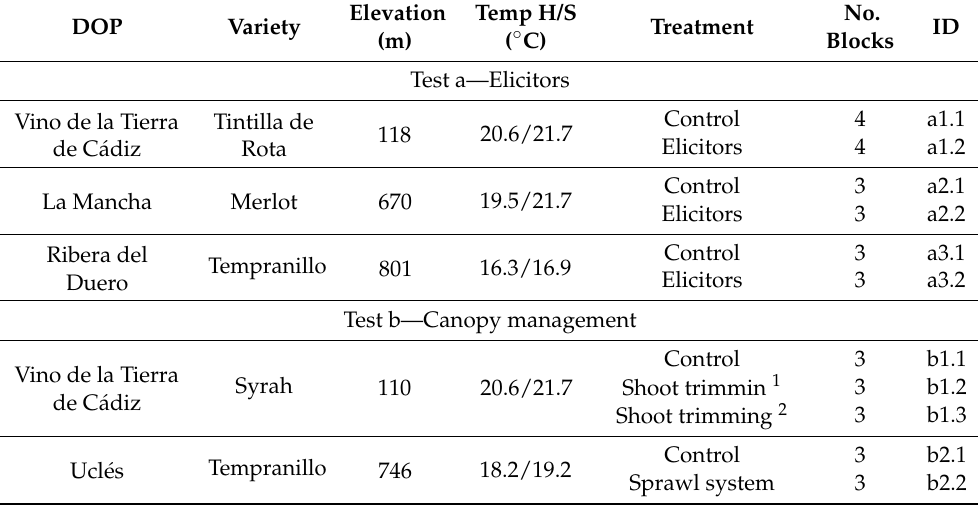
Table 1. Summary of vineyards under study: wine DOP (protected denomination of origin in Spanish), variety, treatment and number of blocks involved. DOP